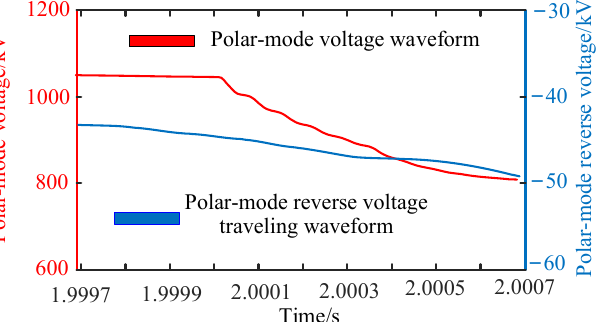
Figure 16. Characteristics of R 1 fault traveling wave of line L 2 bipolar metallic short circuit protec ‐ tion.